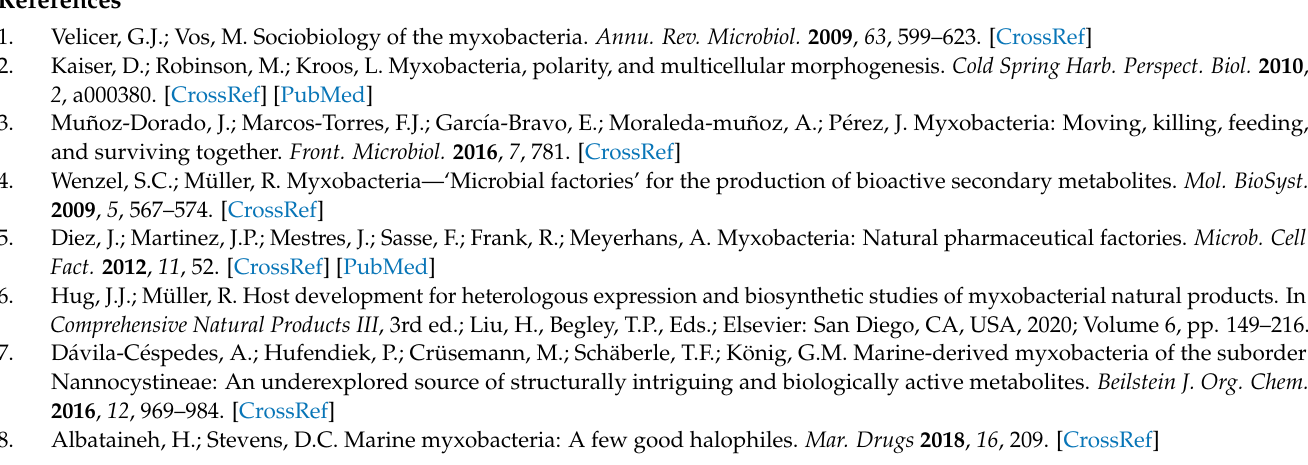
Figure S1: Construction of M. xanthus::miu; Figure S2: Construction of M. xanthus::miu ∆ miuD; Figure S3: Construction of M. xanthus::miu ∆ miuE; Figure S4: Construction of M. xanthus::miu ∆ miuF; Figure S5: Construction of M. xanthus::miu ∆ miuG; Figure S6: Construction of M. xanthus::miu ∆ orf25–29; Figure S7: Construction of M. xanthus::miu ∆ orf25–29&1–10; Figure S8: Construction of M. xanthus::miu ∆ orf25–29&14–16; Figure S9: Construction of M. xanthus::miu ∆ orf25–29&19–23; Figure S10: Mass spectra of 1 and its congeners. Figure S11: Production of miuraenamide A (1) and its congeners via M. xanthus::miu mutant fed on bromotyrosine. Figure S12: Enantiomeric excess of 3-bromo-D- and L-tyrosines determined through Marfey’s